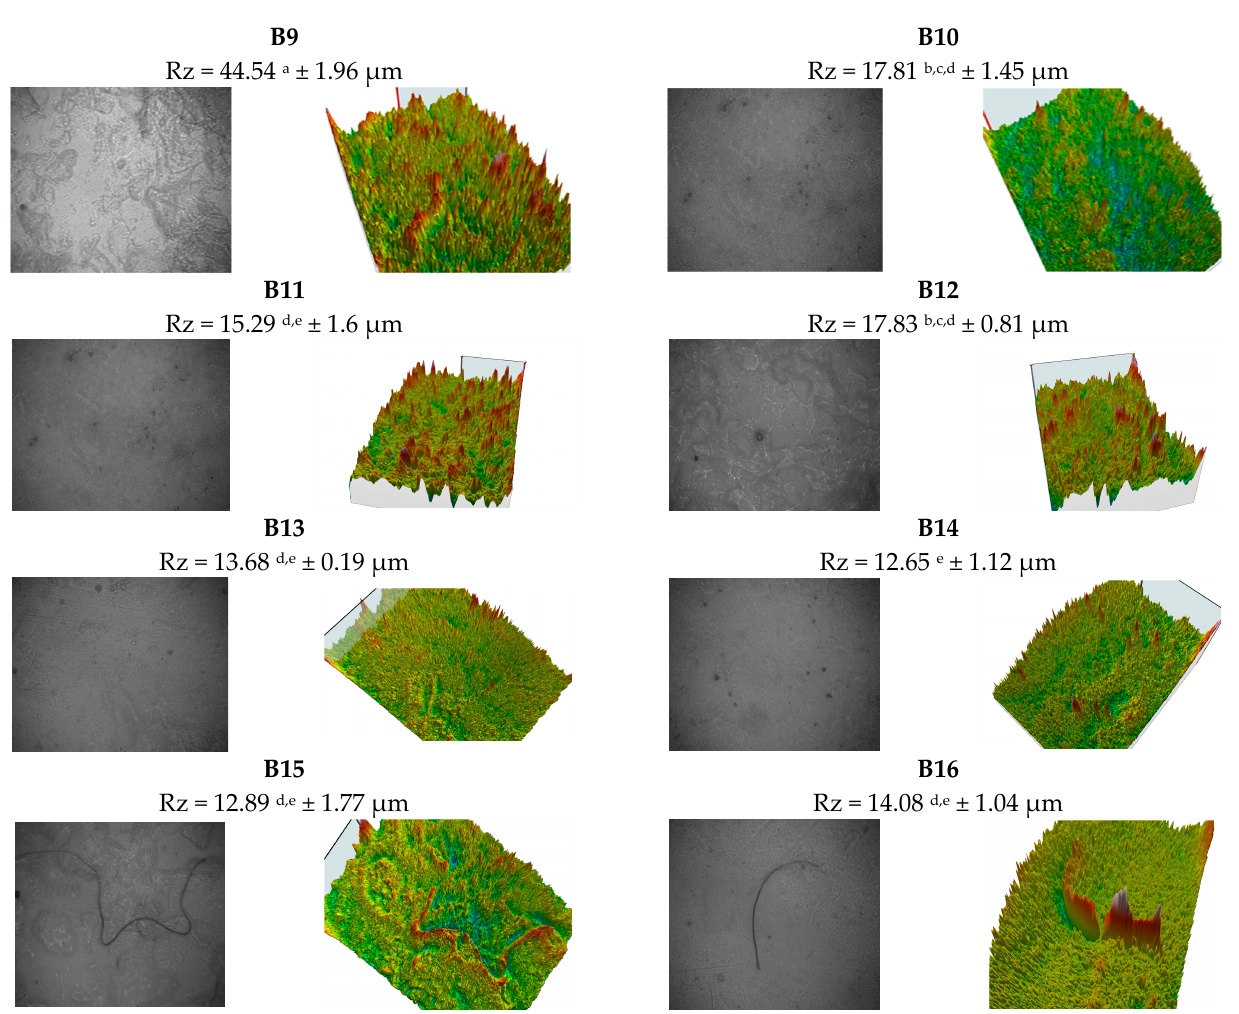
Figure 2. SEM images and microtopographies of the tested foils. Values (a–e) followed by the same letter are not significantly different ( α : 0.05).